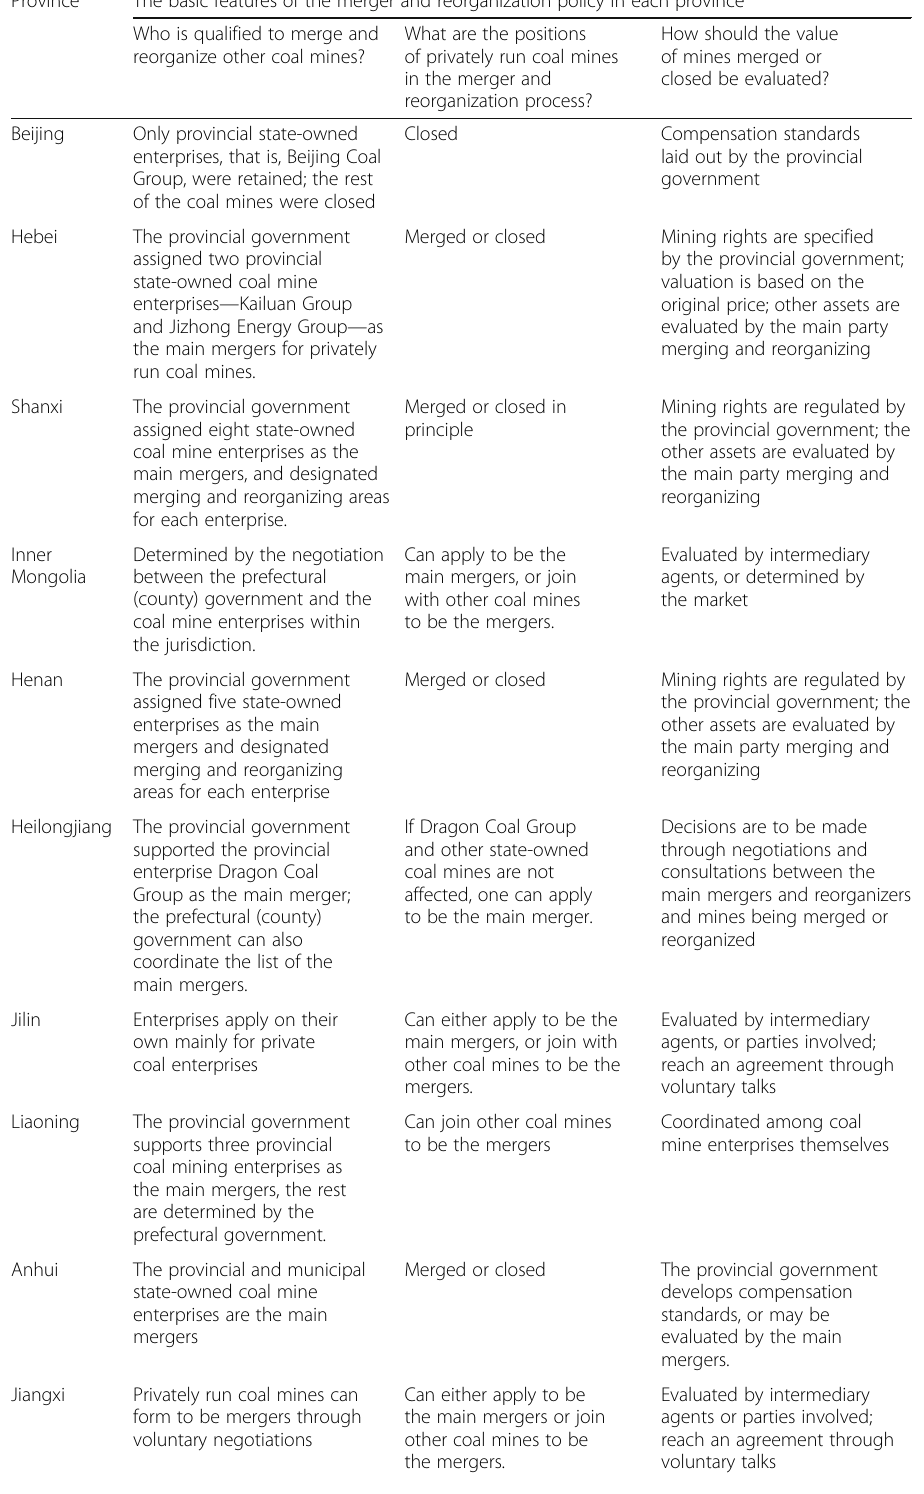
Table 2 Basic features of the mergers and reorganizations policy for each province (including autonomous regions and